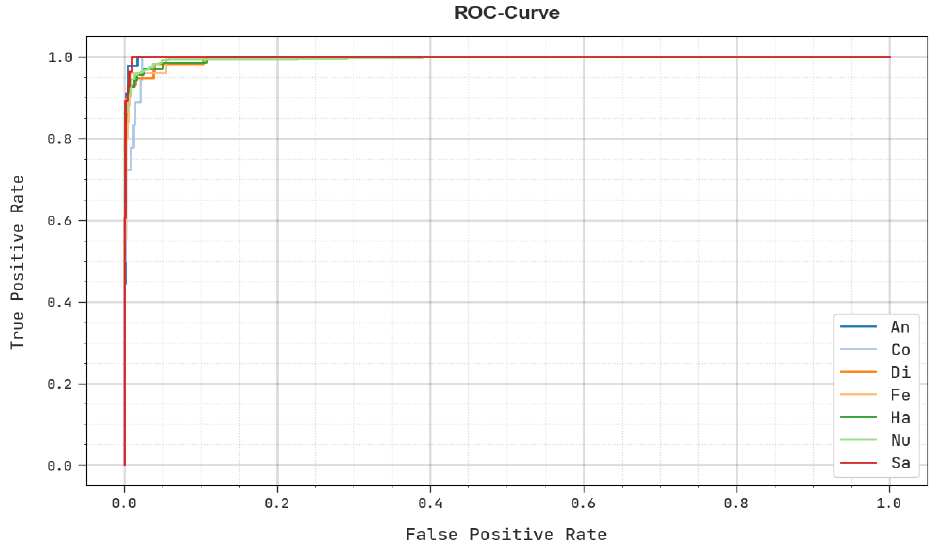
Figure 12. Precision – recall analysis of the RFER-EADL algorithm.